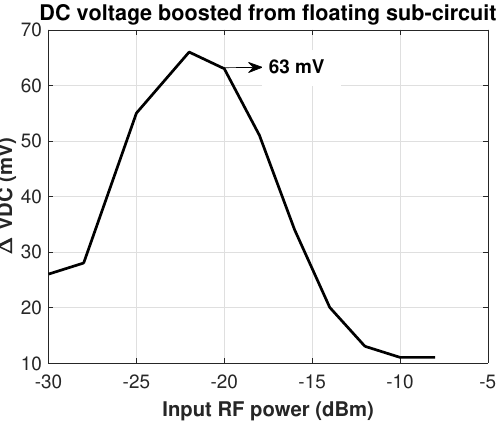
Figure 4. Simulated DC level-up amount ( ∆ V DC ) from the floating sub-circuit.